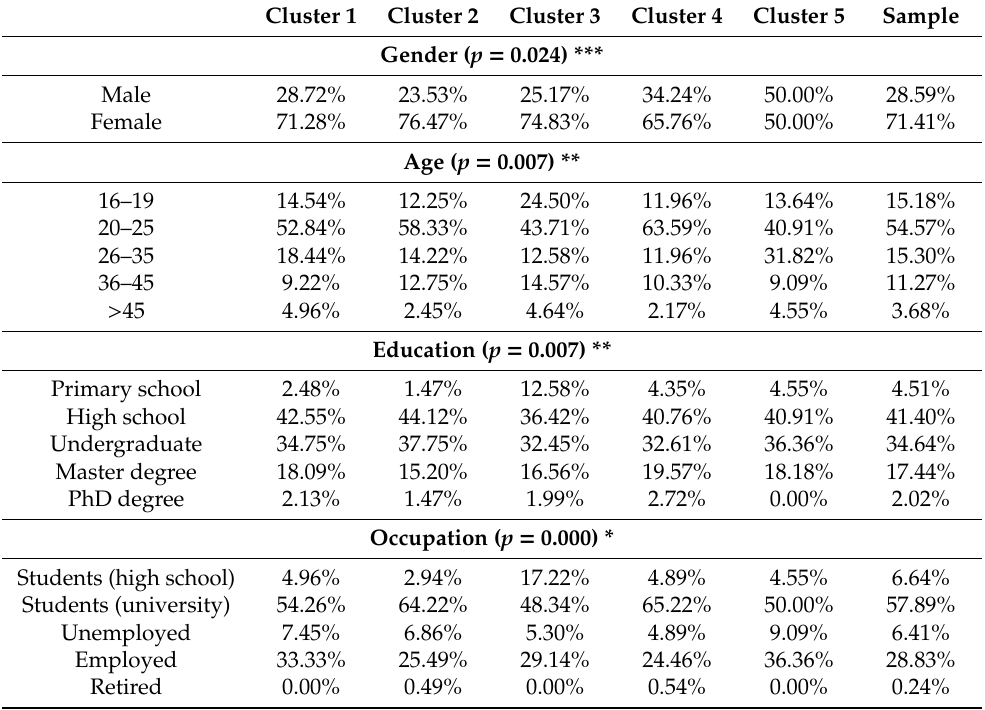
Table A1. Socio-demographic data across clusters.